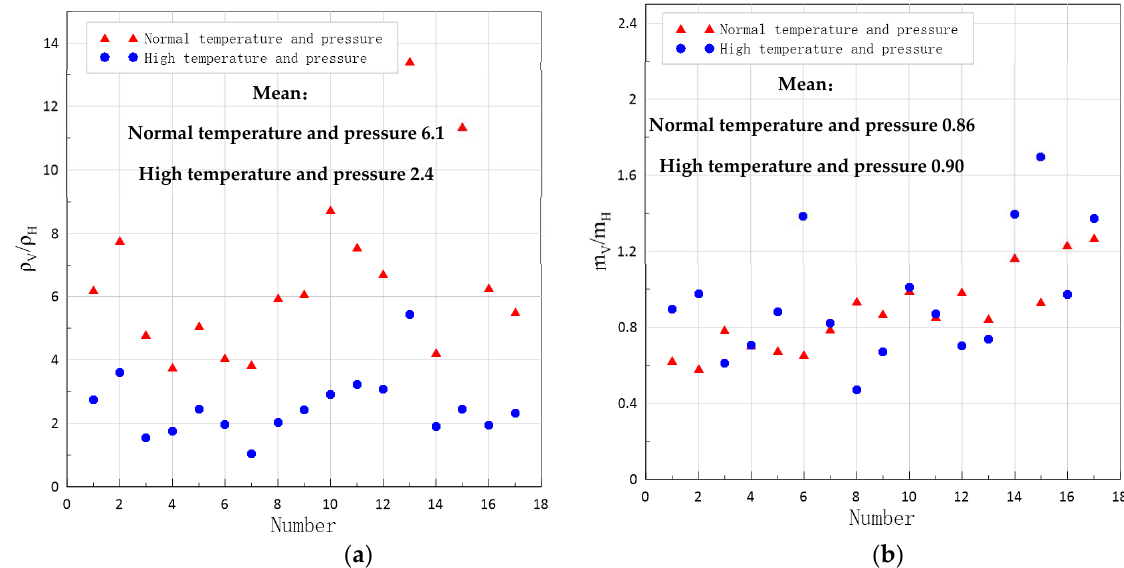
Figure 12. Anisotropy coefficient of resistivity and polarizability under normal temperature and pressure, high temperature and pressure. ( a ) resistivity; ( b ) polarizability.